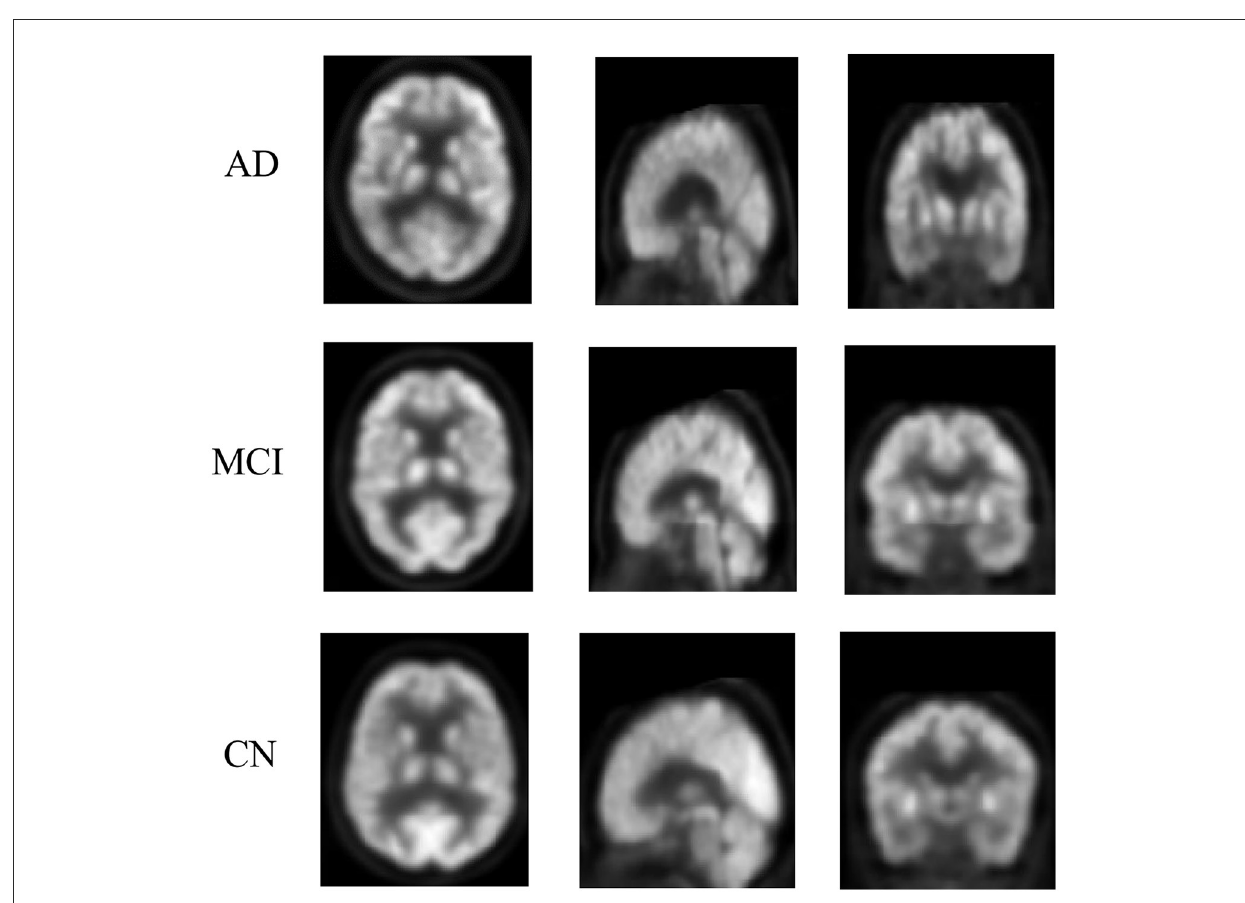
FIGURE1 Example of FDG-PET imaging from ADNI. Each row represents a PET imaging slice on a three-plane view. The three rows are: a 73-year-old man with AD, an 81-year-old woman with MCI, and a 71-year-old man without MCI/AD. The difference between them is difficult to identify with the naked eye.